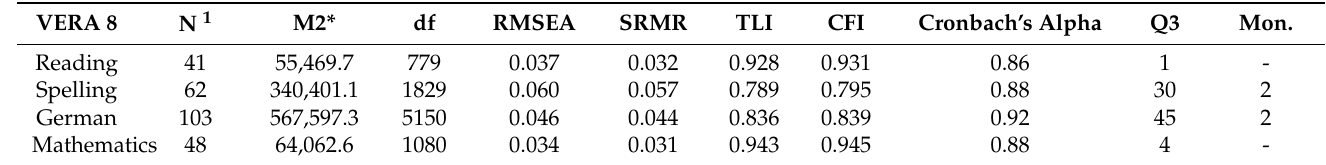
Table 3. Results of Rasch model assumptions: unidimensionality, reliability, local independence, and